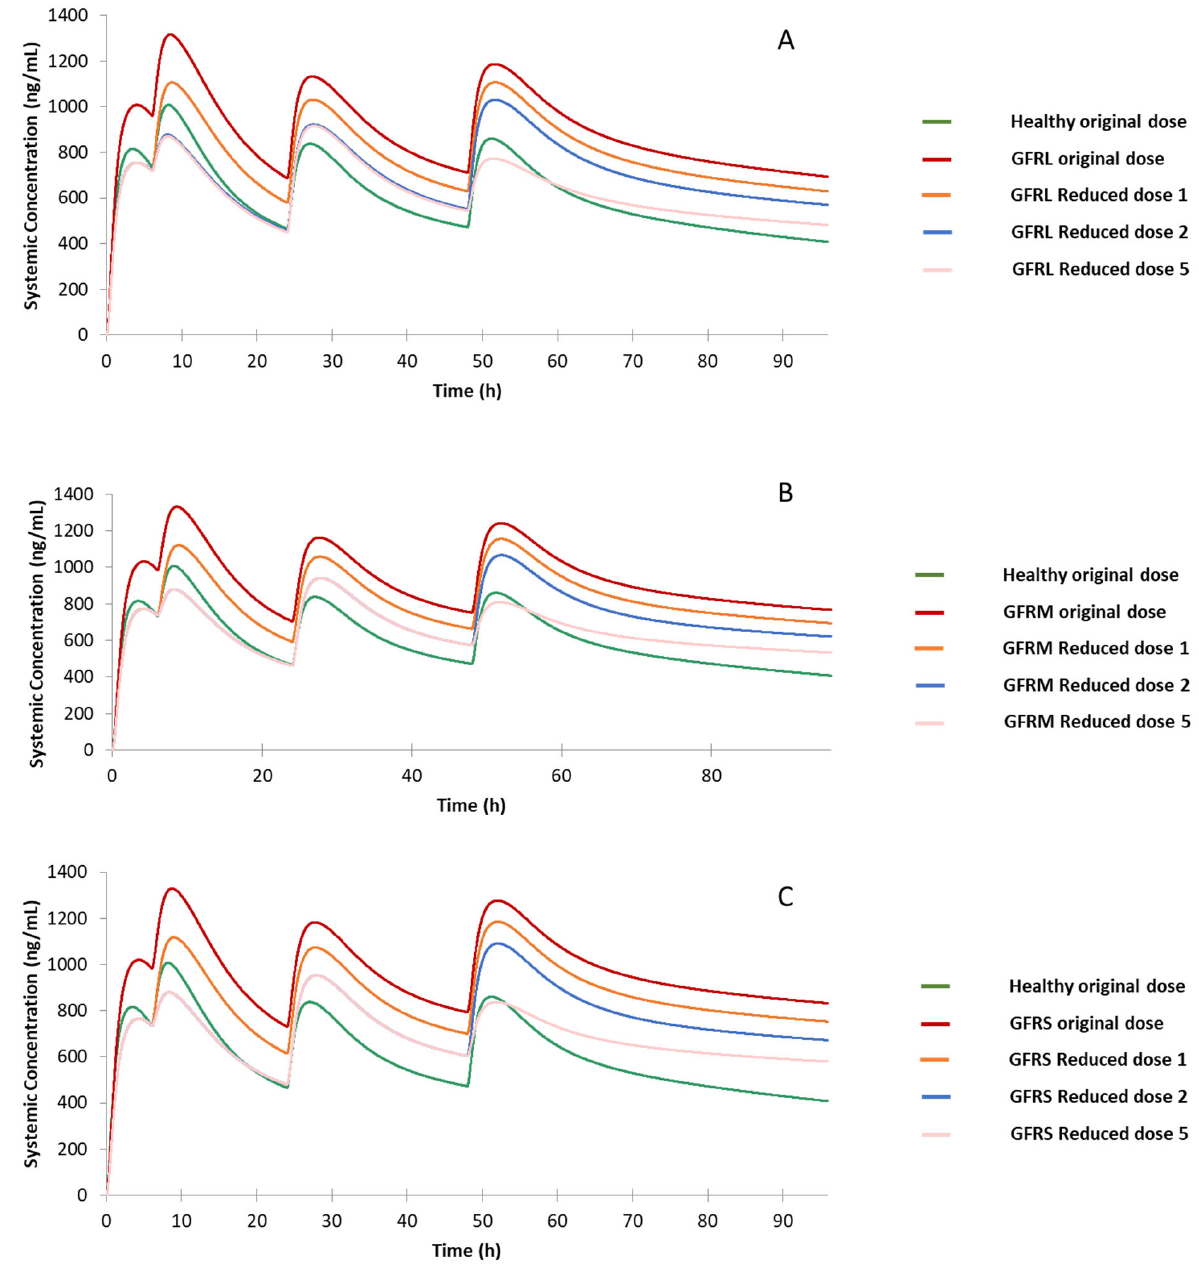
Figure 8. Predicted drug concentration for the healthy population under original dose, renal impair- ment populations under original dose, and renal impairment populations under Reduced dose 1, 2, and 5. ( A ): renal impairment mild. ( B ): renal impairment moderate. ( C ): renal impairment severe. GFRL: mild renal impairment population, GFRM: moderate renal impairment population, GFRS: severe renal impairment populations.